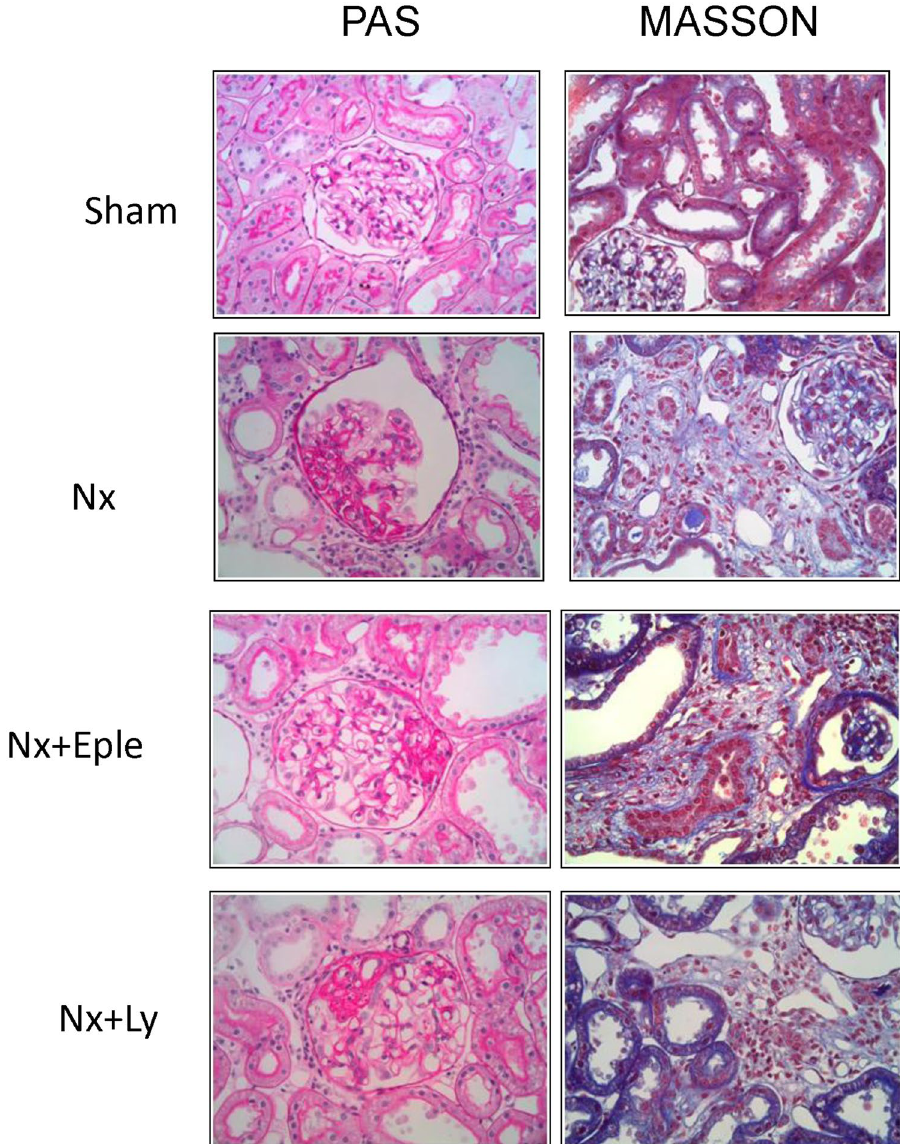
Figure 3. Representative photomicrographs (x400) of PAS-stained (for glomerulosclerosis) and Masson- stained (for cortical interstitium) renal tissue in the four groups studied in Protocol 1 (early